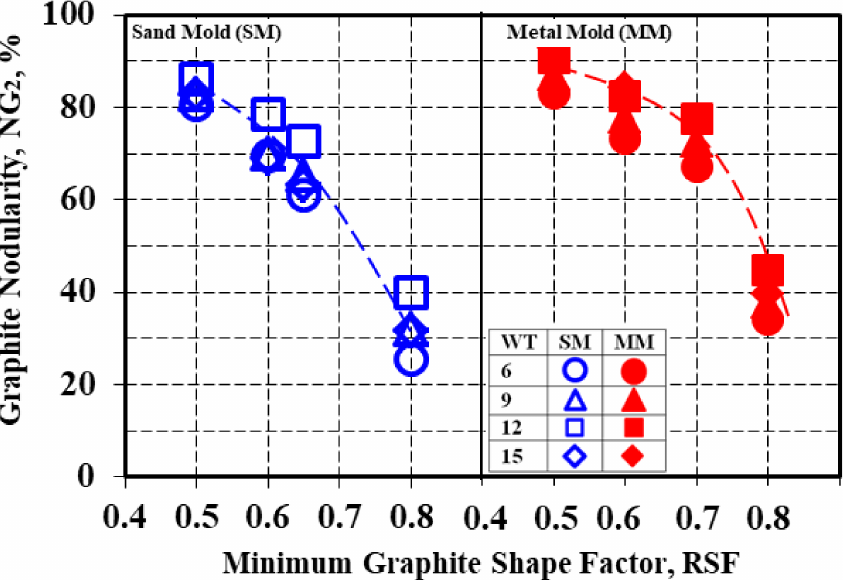
Figure 14. Influence of the minimum imposed RSF on the graphite nodularity NG 2 as effects of the mold media and wedge casting wall thickness (mm).